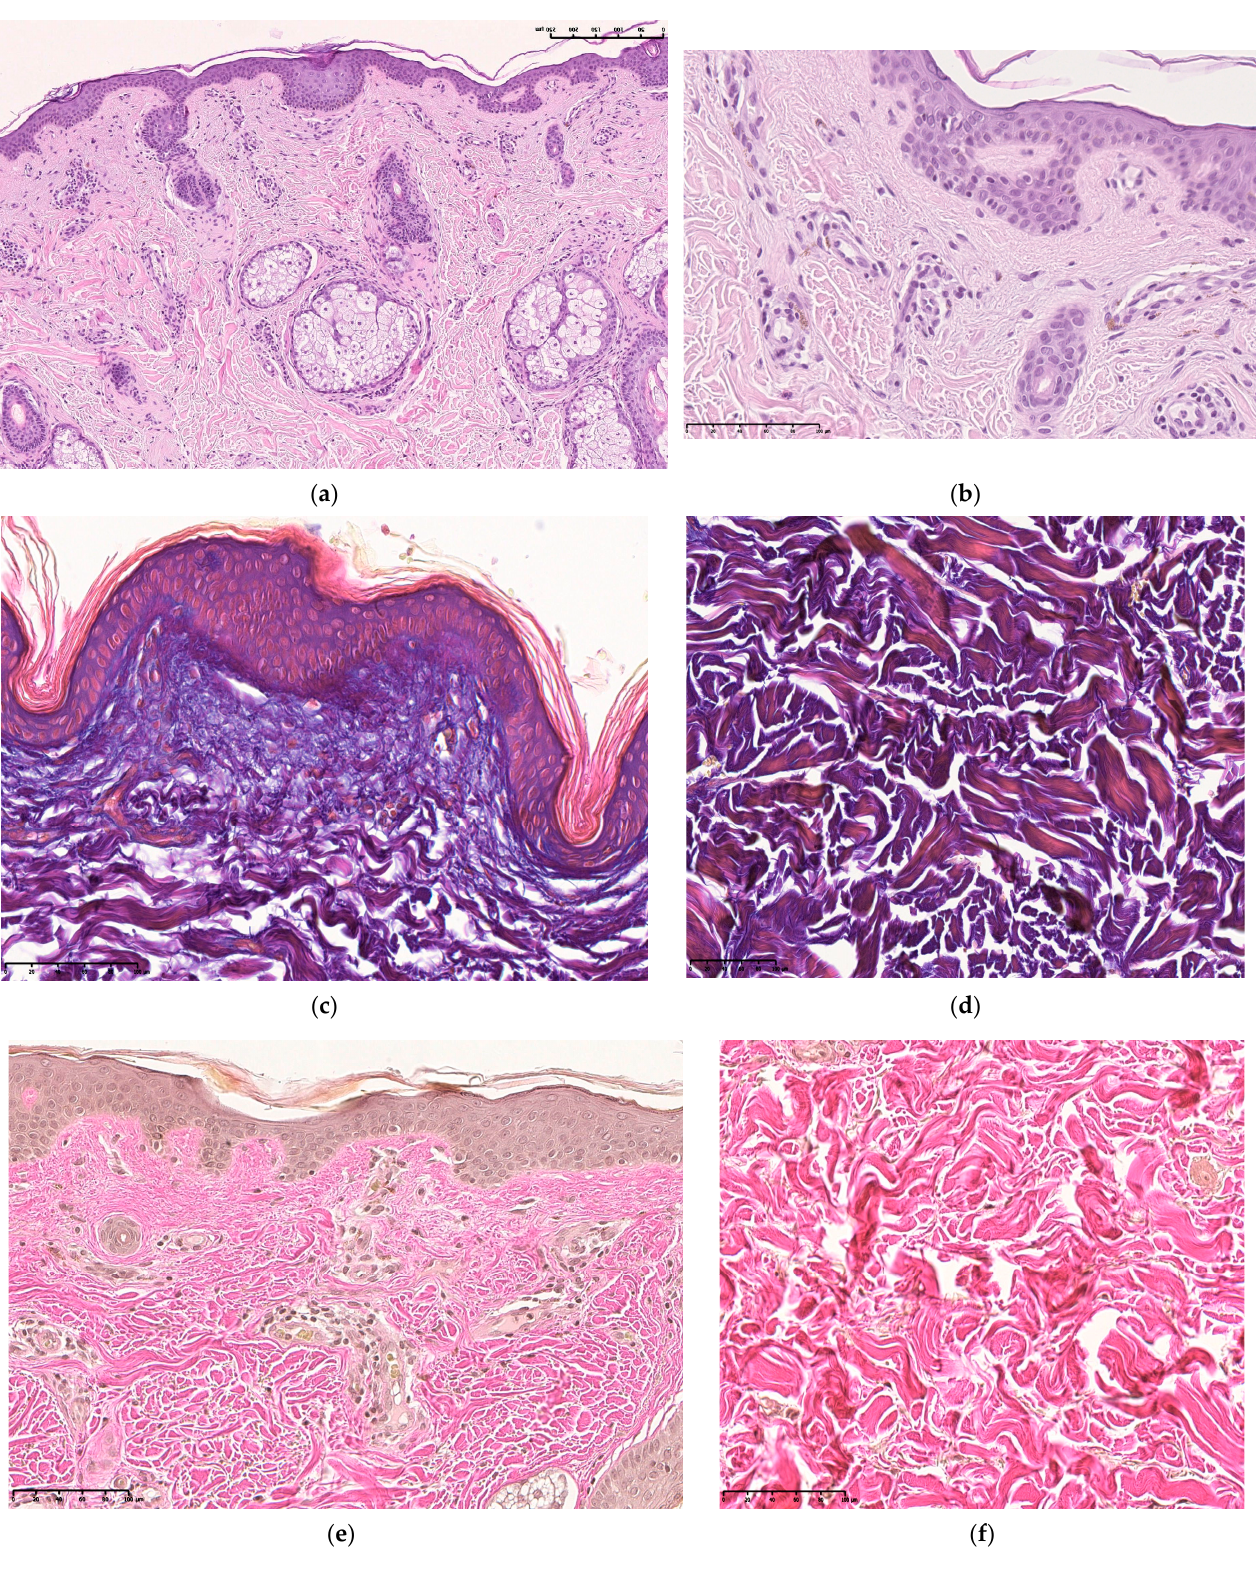
Figure 4. Micrography of the skin section in the comparison group is an intact skin area of patients with normal skin aging: ( a , b ) stained with hematoxylin and eosin, ( c , d ) stained according to the Mallory method, ( e , f ) stained according to the Van Gieson method. ×100 ( a , e ), ×200 ( b – d , f ). The dermis is formed by papillary and reticular layers. The border between the epi- dermis and the dermis is smoothed, the epidermal papillae are short and wide. The papil- lary layer of the dermis is formed by loose fibrous connective tissue, the fibrous compo- nent of which is formed by fibers arranged randomly and disordered, without a tendency to form bundles. Connective tissue fibers are thin, and the degree of their heterogeneity is poorly expressed. The cellular component is heterogeneous in its composition. The border between the papillary and reticular layers is moderately pronounced; there is a smooth transition of one type of connective tissue to another (Figure 4c,d). The reticular layer is formed by dense irregular connective tissue. Bundles of collagen fibers oriented in differ- ent directions are visualized in its thickness. The fibrous component prevails over the cel- lular one (the structured substance of the dermis of the skin). Inter-fiber spaces (unstruc- tured matter) are visualized between bundles of connective tissue fibers (Figure 4d,e). Histological examination of skin sections of patients with premature aging revealed a decrease in the thickness of the epidermis, mainly due to a decrease in the number of rows of cells of the spinous layer. The rate of keratinization of the epidermis is increased, the morphological manifestation is an increase in the thickness of the stratum corneum and its detachment from the underlying layers of the epidermis. The granular layer is weakly expressed. The undulation of the border between the papillary dermis and the epidermis is enhanced. The folding of the skin is more pronounced, the morphological manifestation of which is an increase in the height of the epidermal papillae, which look narrow and long on slices. In the papillary layer of the dermis, the fibers are thinner, the degree of their heterogeneity is pronounced, there is a decrease in the inter-fiber gaps, leading to a decrease in the thickness or its area of the papillary layer. The cell density is slightly higher than in the group of patients with normal skin aging. The border between the papillary and reticular layers of the dermis of the skin is more contrastingly pro- nounced (Figure 5). In the reticular layer, the bundles of collagen fibers are coarse and deformed, and their heterogeneity is pronounced. The area of inter-fiber gaps has been reduced.